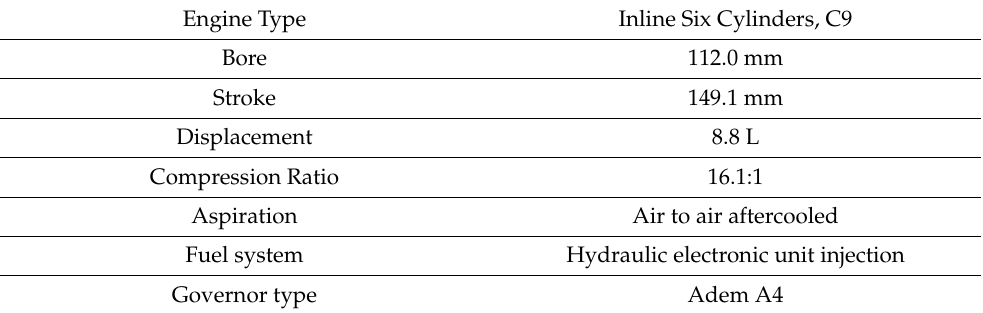
Table 3. Engine Table 3. Engine speci fi cations. Table 3. Engine speci fi cations.